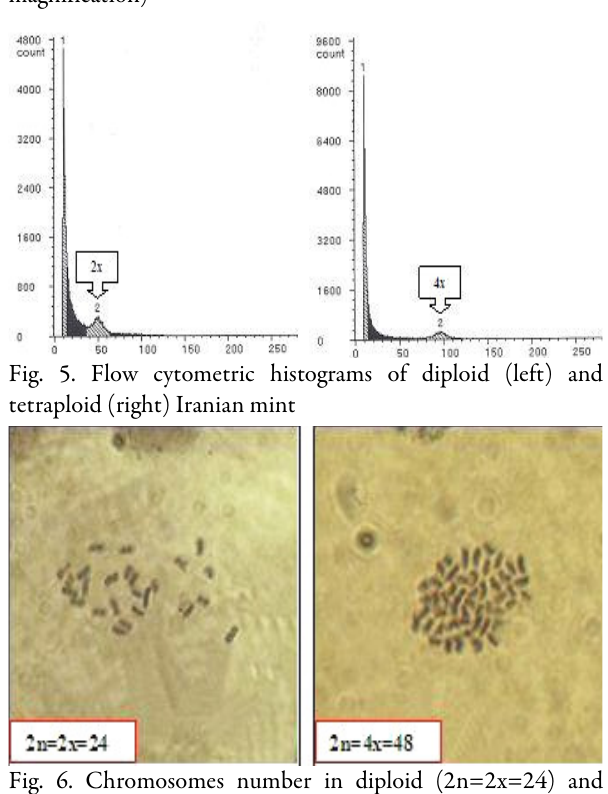
Fig. 6. Chromosomes number in diploid (2n=2x=24) and tetraploid (2n=4x=48) Iranian mint